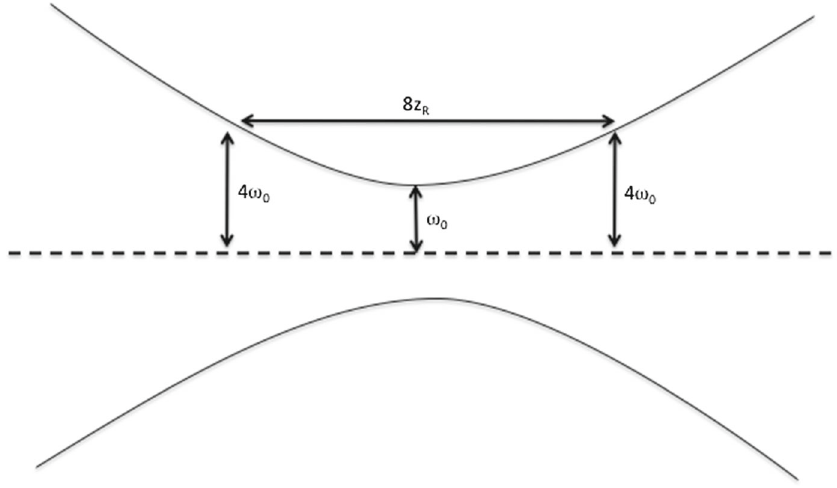
Fig. 3 The change in beam radius over 8 Rayleigh lengths. The beam waist, ω 0 is the point with the smallest